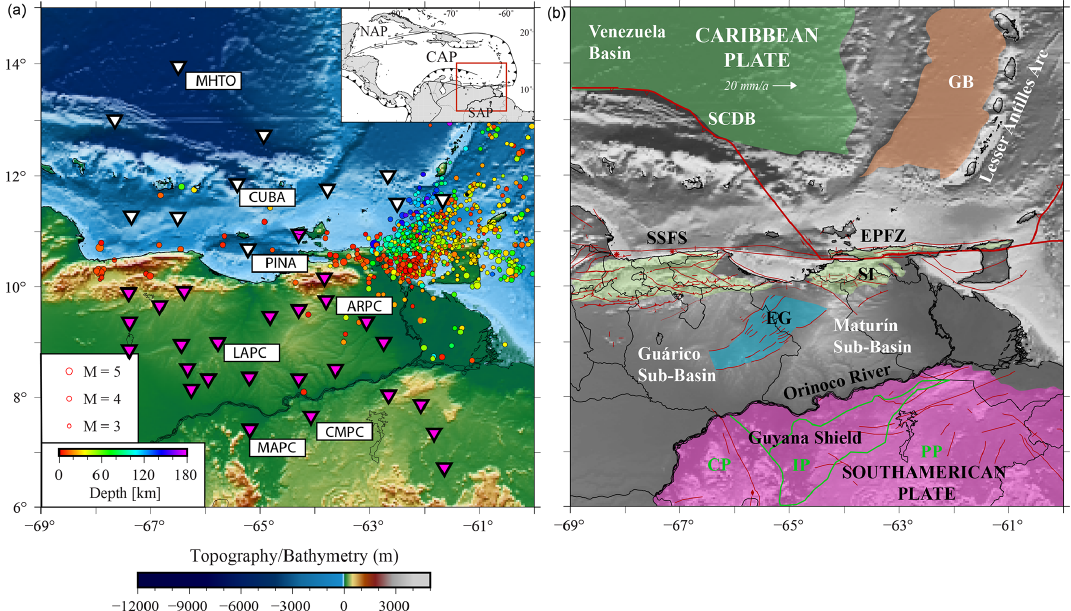
Figure 1. (a) Topographic map of the studied area overlaid with stations (triangles) from the BOLIVAR project (2004–2005). The local seismicity (circles) from 2005–2020 ( M w > 3 . 0) is shown to illustrate the tectonic background and complexity of the study region (see main text). On the top right is a view of the general context of the Caribbean Plate and northern South America. Blue triangles represent stations inland, while white triangles represent OBS. Labeled stations are later used to illustrate methodology and results. (b) Simplified geologic map of the studied region. The Precambrian shield is shown in purple, the Jurassic Espino Graben (EG) in blue, in green the Serranía del Interior (SI), in dark green the Cretacic Venezuela Basin and in brown the Grenada Basin. In red we show active faults as presented by Audemard et al. (2006). Other abbreviations include SSFS (San Sebastian Fault System), EPFS (El Pilar Fault System), Trinidad and Tobago (TT), Peninsula of Paria (PoP), Cuchivero Province (CP), Imataca Province (IP), and Pastora Province